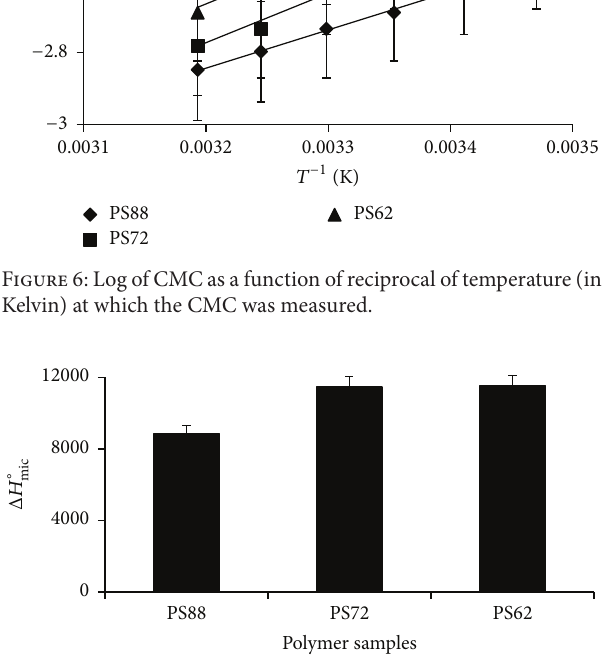
Figure 7: Δ𝐻 ∘ micellization for various polymer